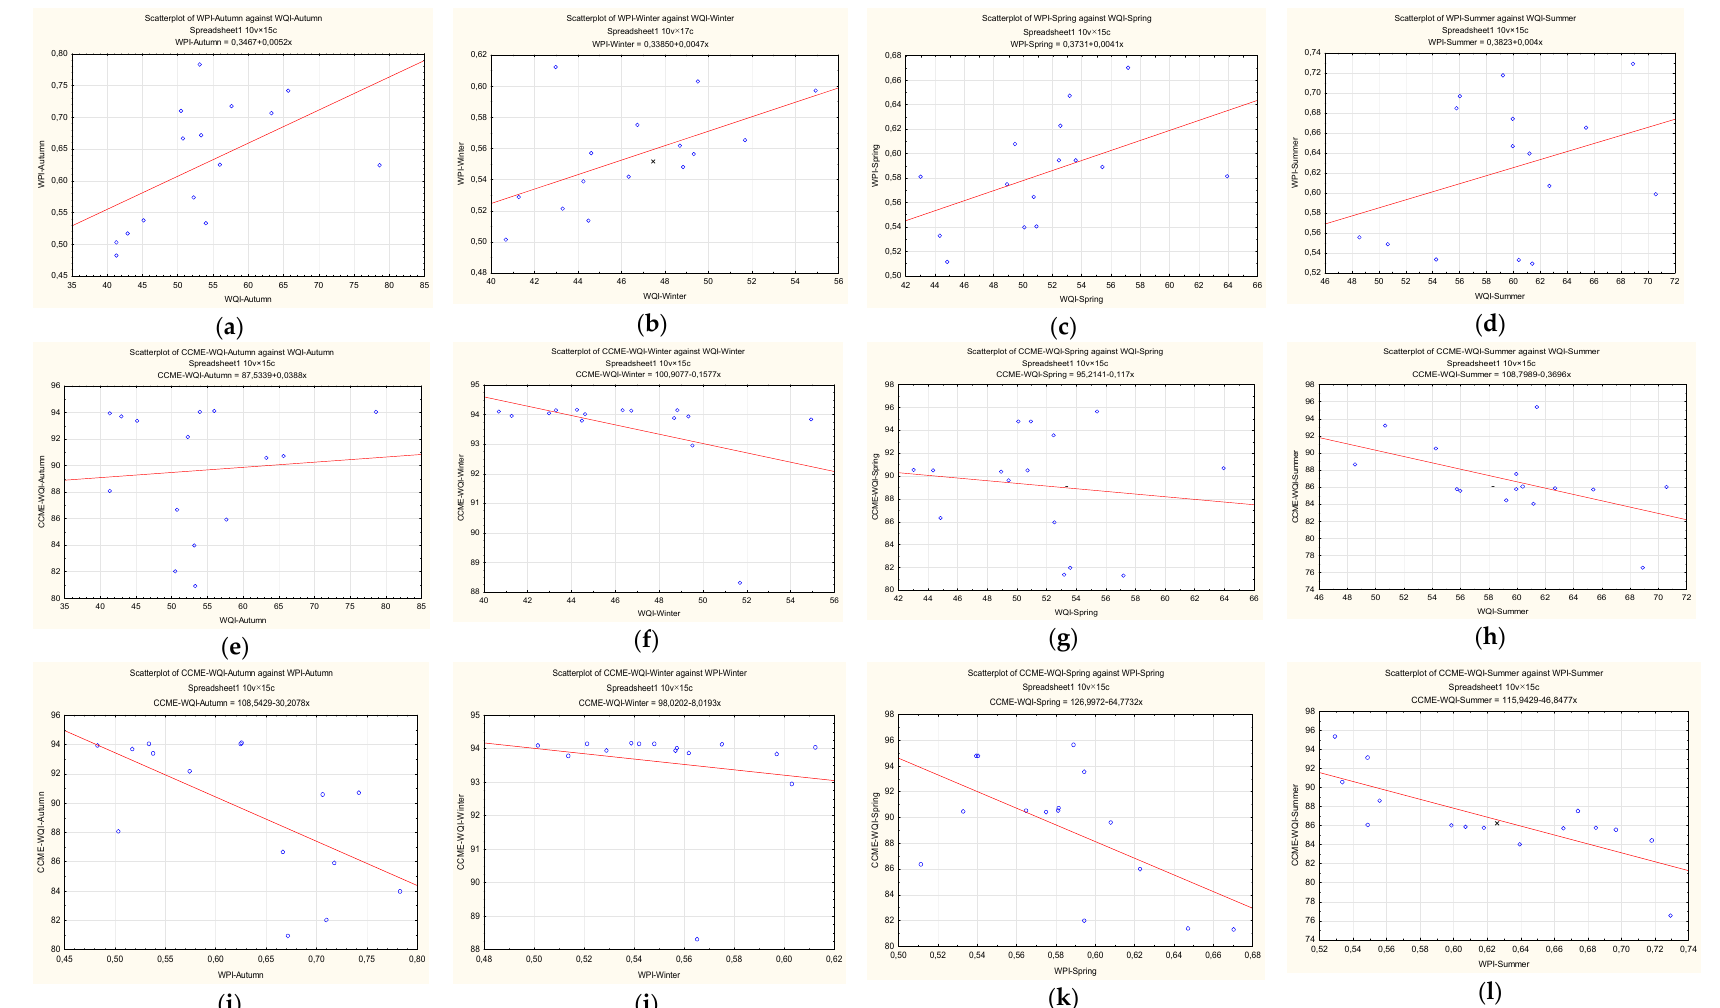
Figure 7. Scatterplots showing the relationships between WPI vs. WQI ( a , b , c , d ), CCME-WQI vs. WQI ( e , f , g , h ) and CCME-WQI vs. WPI ( i , j , k , l ).